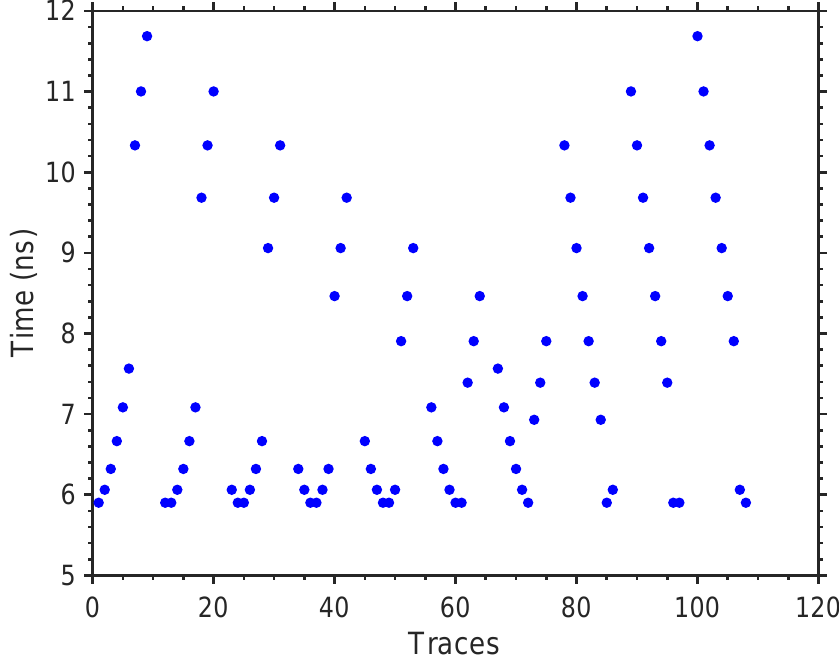
Figure 3. Zero points of the lunar surface calculated by the radar echoes received by the antennas #1 to #10. The blue dots represent the two-traveling time delay of the lunar ground surface reflector of the radar echoes received by the